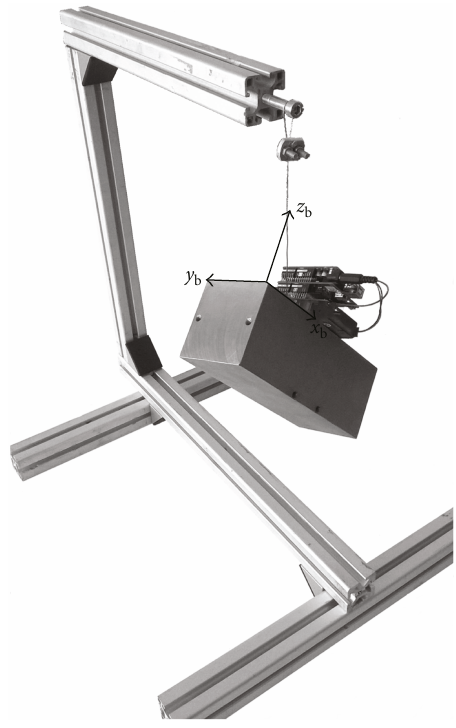
Figure 2: Experimental setup; two consecutive suspensions as the one shown are required to locate the